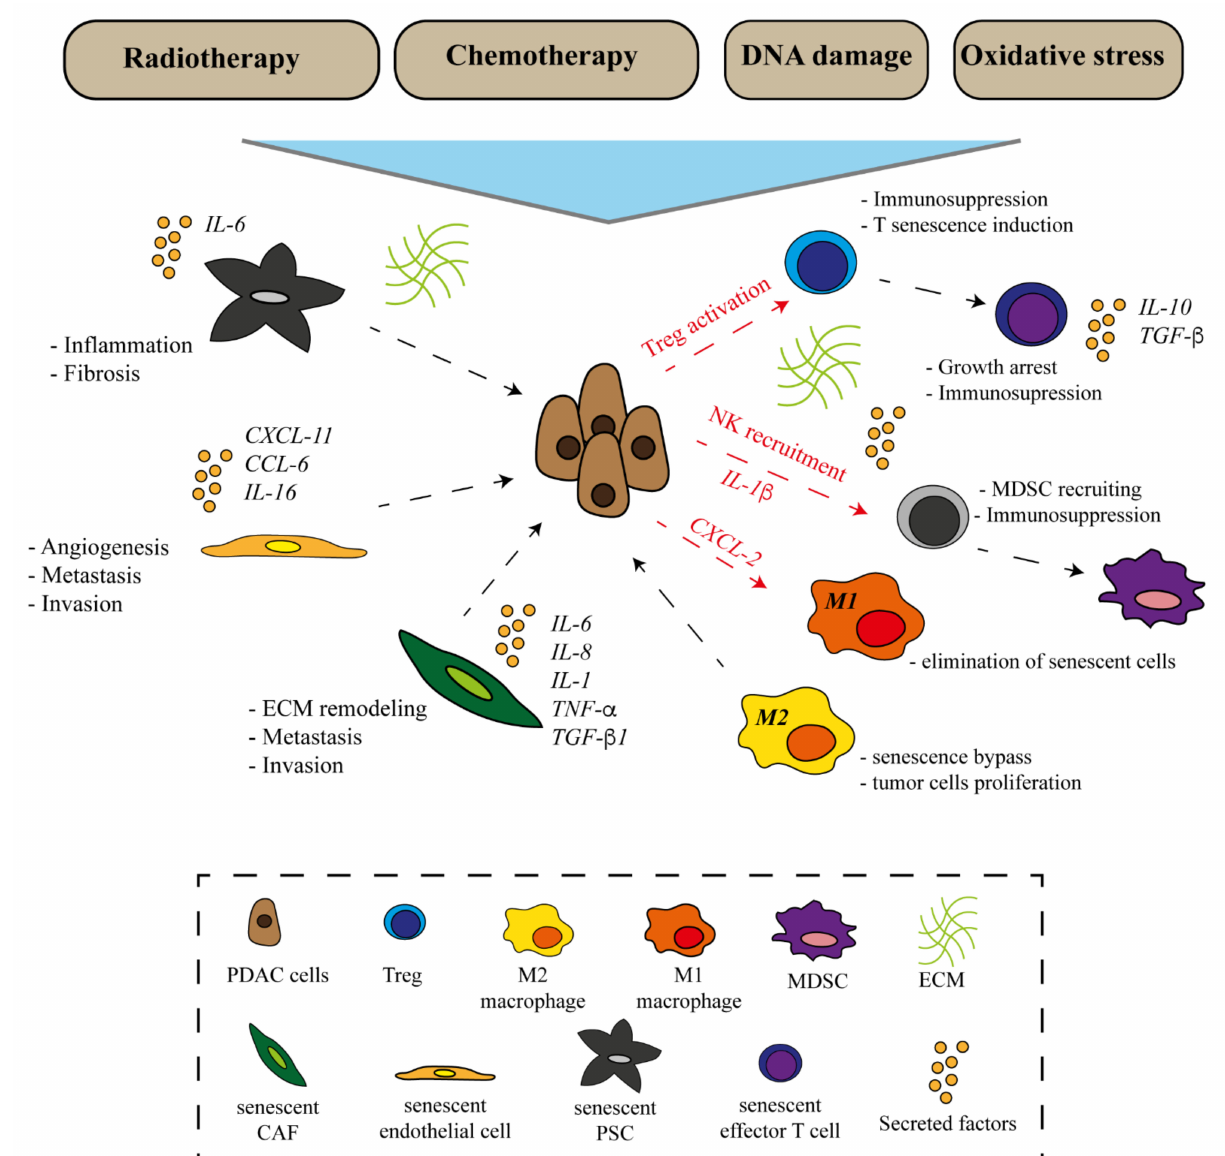
Figure 2. Cross-talk between tumor cells and senescent non-tumor cells in PDAC microenvironment. Abbreviations: PDAC, pancreatic ductal adenocarcinoma; CAF, cancer-associated fibroblast; PSC, pancreatic stellate cell; TAM, tumor-associated macrophage; MDSC, myeloid-derived suppressor cell; Treg, regulatory T cell; ECM, extracellular